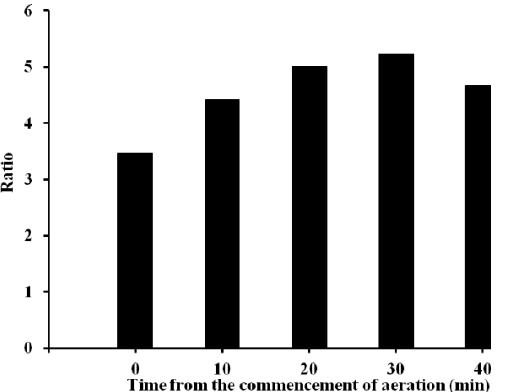
Figure 4. Ratio of NO 2− -N accumulation rate to NO 3− -N accumulation rate under the different non-aeration durations.